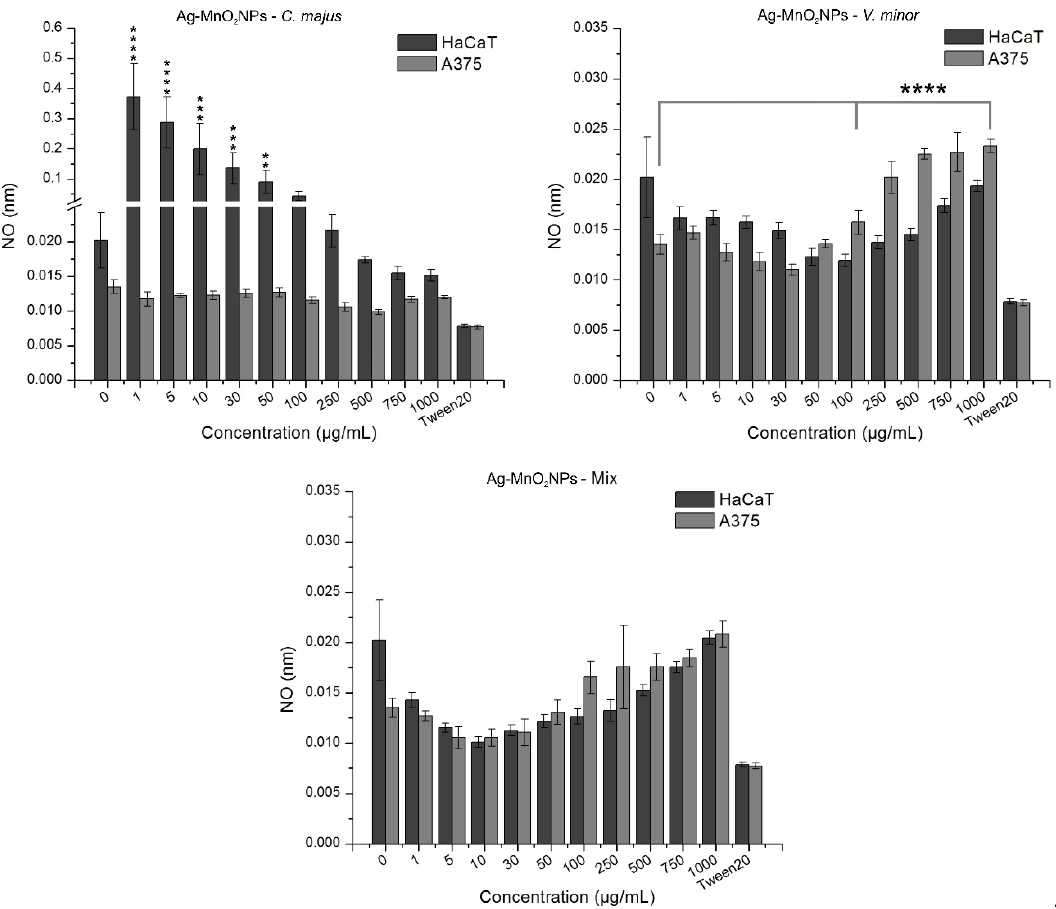
Figure 8. In vitro analysis of the NO release by normal keratinocytes (HaCaT) and skin melanoma (A375) cells treated with green synthesized Ag-MnO 2 NPs using the three plant extract formulations; ****: p < 0.0001, ***: p < 0.005, **: p < 0.05.